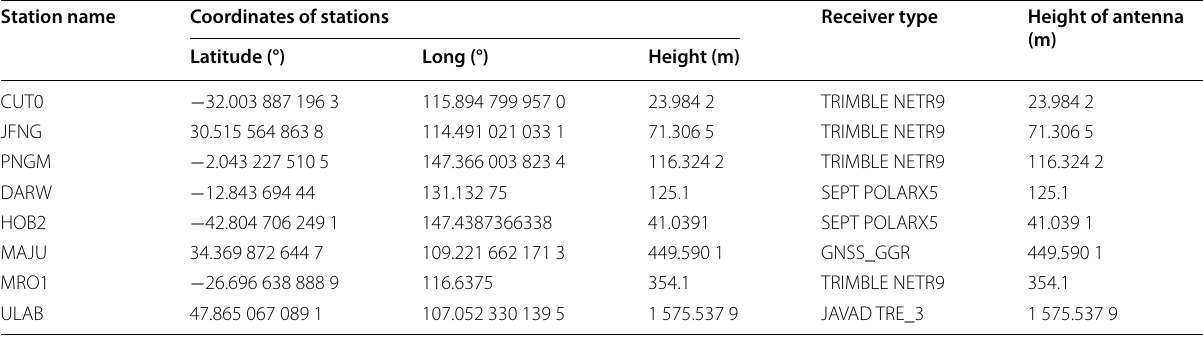
Table 1 The details of the stations, including the receiver type, antenna type, and the locations in the World Geodetic Coordinate System 1984